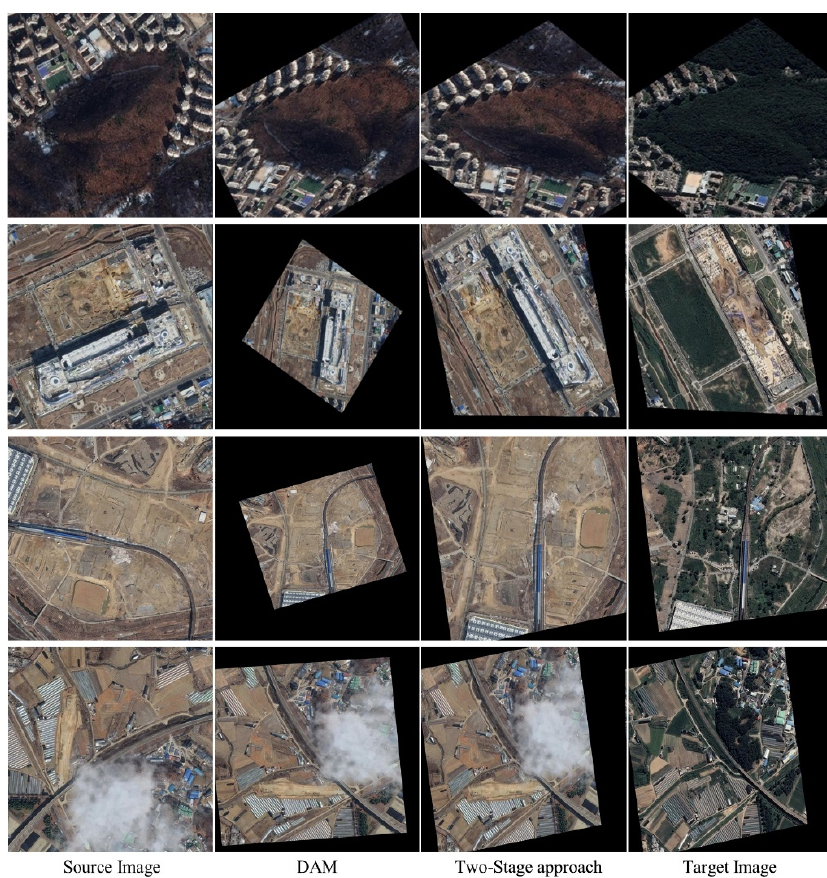
Figure 16. The registration results of images with massive changes.